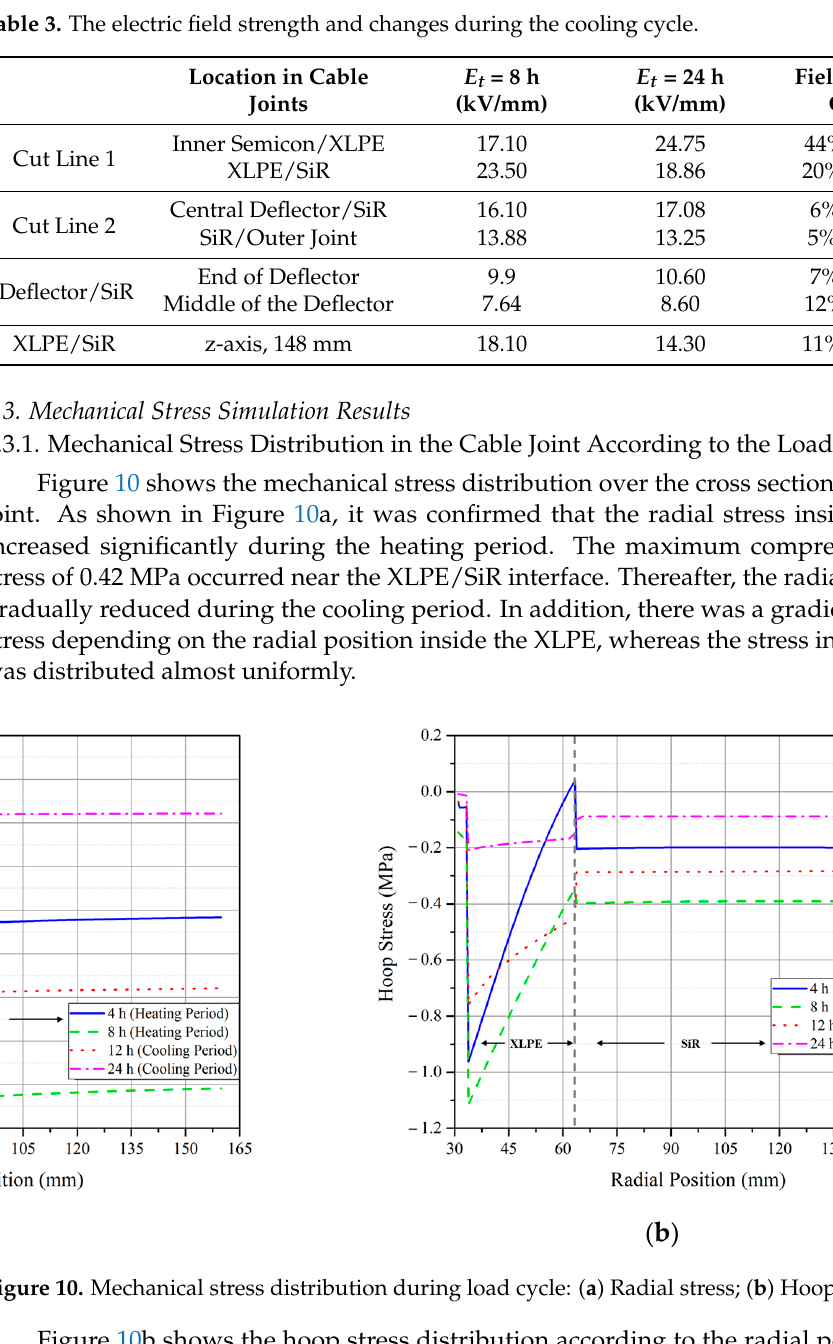
Figure 9. Time-varying electric field distribution at XLPE/SiR interface: ( a ) Electric field intensity at the interface; ( b ) Tangential electric field intensity at the interface. Table 3. The electric field strength and changes during the cooling cycle.